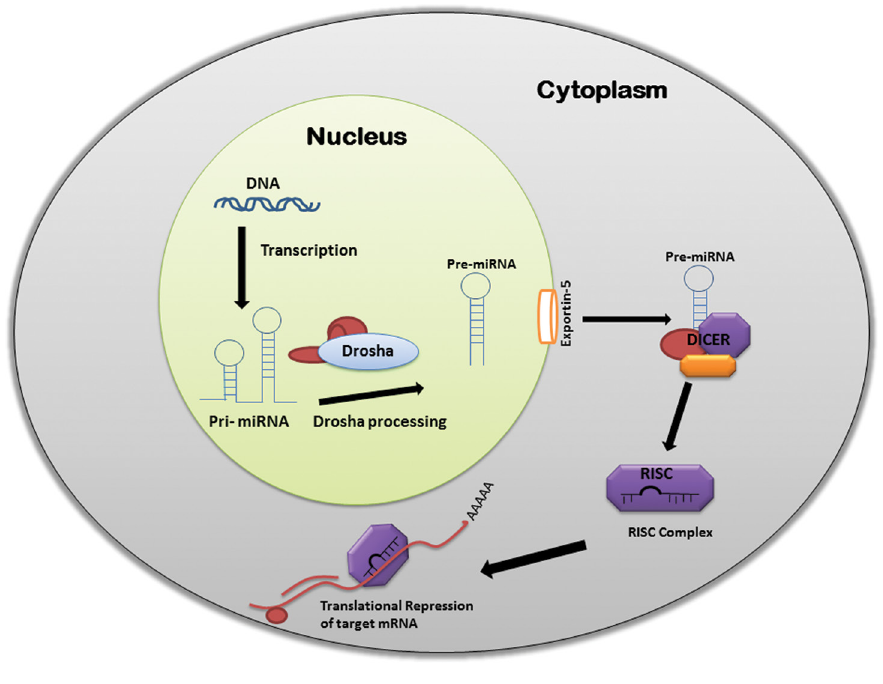
Figure 1. Simplified diagram of general miRNA biogenesis. Complementary DNA of pri-miRNA synthesize hairpin structure Pre miRNA that carries 5 ¢ Cap and 3 ¢ poly A tail. Drosha and DGCR8 of dsRNA–binding protein complex cleaves nearly 55-70 nt long Pre- cursor miRNA (pre-miRNA) and it is exported from nucleus to cytoplasm using Exportin 5 enzymes. Pri miRNA together with Dicer and TAR RNA binding protein (TRBR) or PACT remove the loop and produce miRNA duplex from precursor RNA. MiRNA duplex is loaded to RISC complex and synthesized the mature miRNA for translation repression and transcriptional